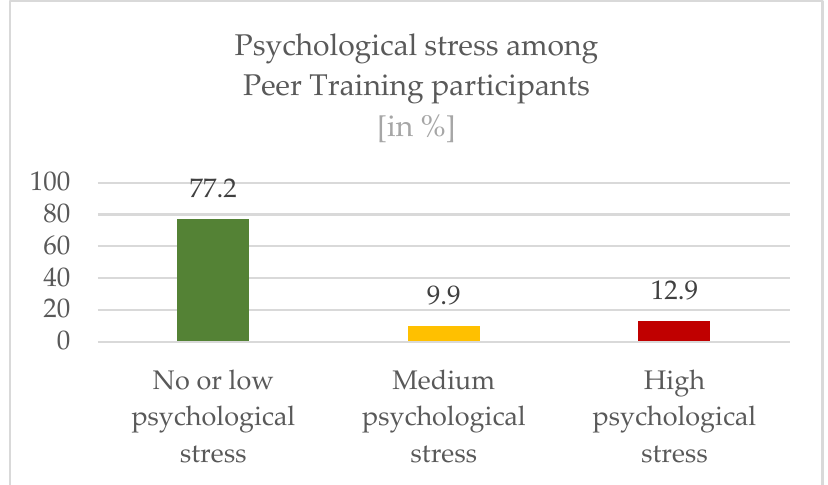
9 of 16 Figure 4. Medical care levels of the participants’ organizations.